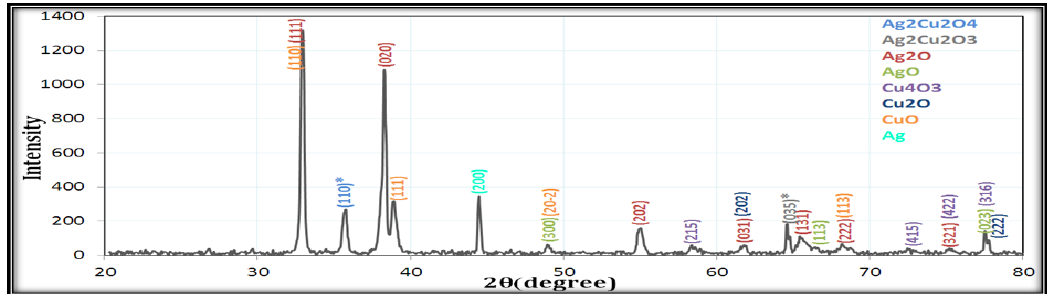
Fig.3: The X-ray diffraction pattern of Ag